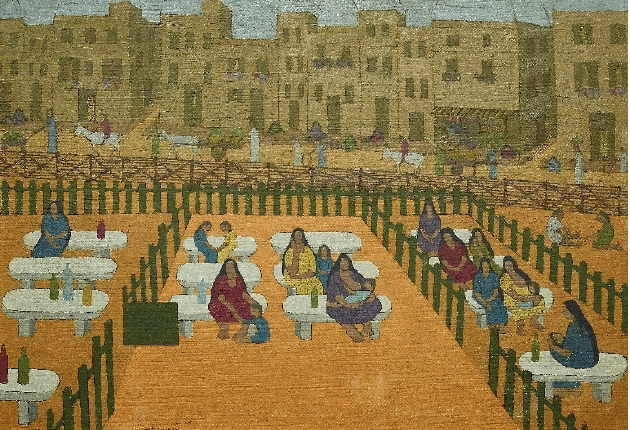
Figure 7. Menhat Helmy, Outpatient Clinic (1958). Oil on canvas, 66 × 80 cm. Image, courtesy of Barjeel Art Foundation, Sharjah.